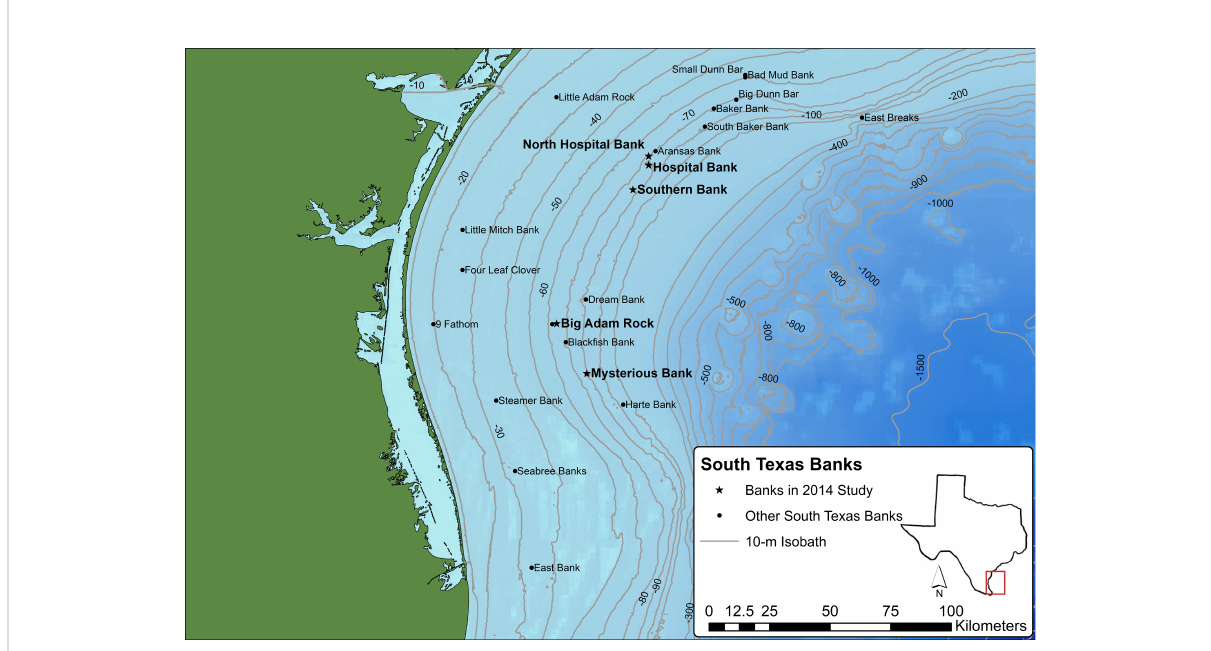
FIGURE 1 Locations of the South Texas Banks in relation to the coast of South Texas. The fi ve banks studied for this research are denoted with stars. Basemap modi fi ed from data from Esri, Delorme, GEBCO, NOAA, NGDC, National Geographic, HERE, Geonames.org, and other